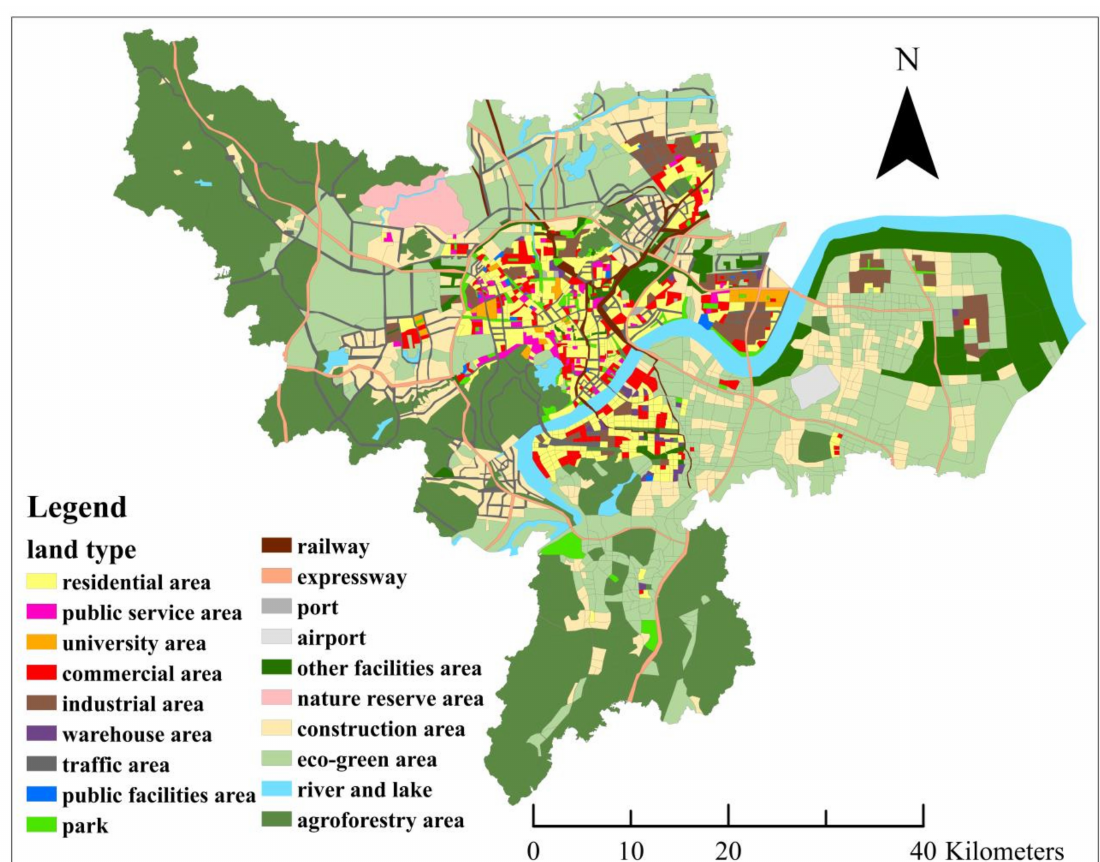
Figure 12. Master plan of Hangzhou city